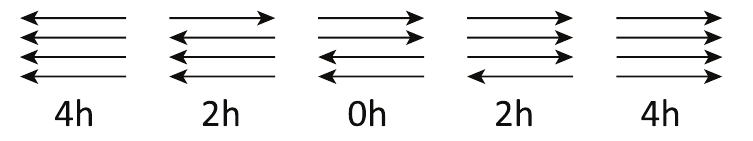
Figure 2. Singularity